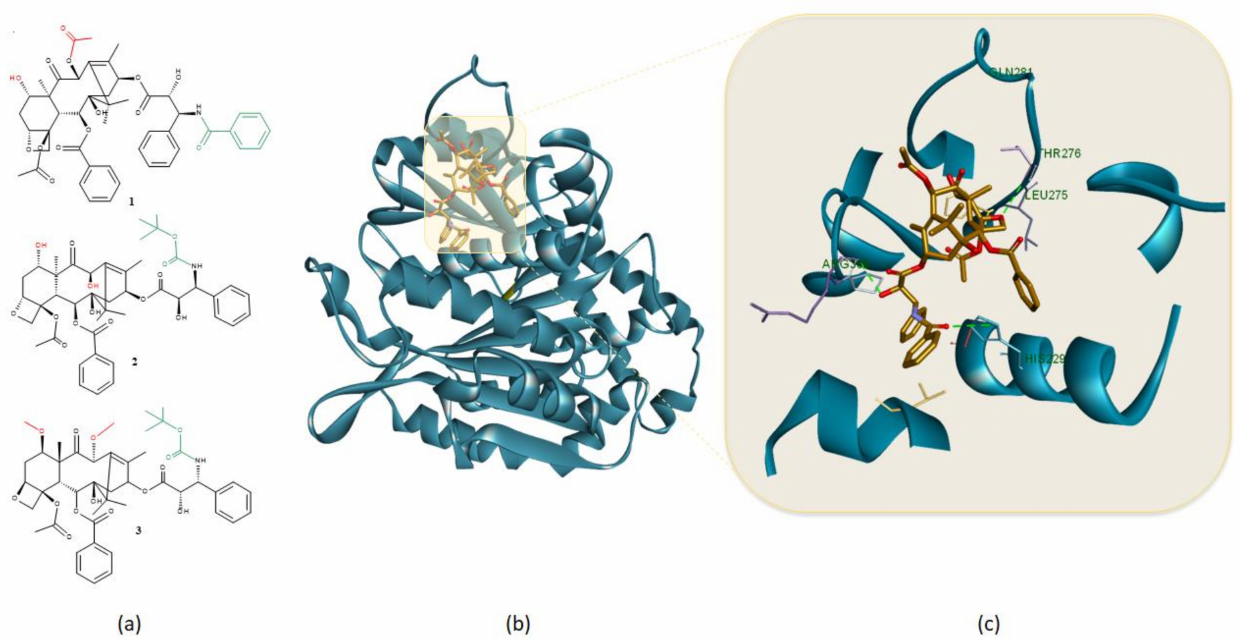
Figure 3. ( a ) Chemical structures of (1) paclitaxel, (2) docetaxel, and (3) cabazitaxel, major structural differences are highlighted in green while alkylation/acylation of OH groups is highlighted in red; ( b ) 3D structure of stabilized microtubule chain A (blue) (PDB ID: 5SYF) in complex with taxol (gold) and ( c ) important HBs (green dotted lines) formed by the taxane structure within the β -tubulin binding site. Protein-ligand representation was achieved using Biovia Discovery Studio 4.1 (Dassault